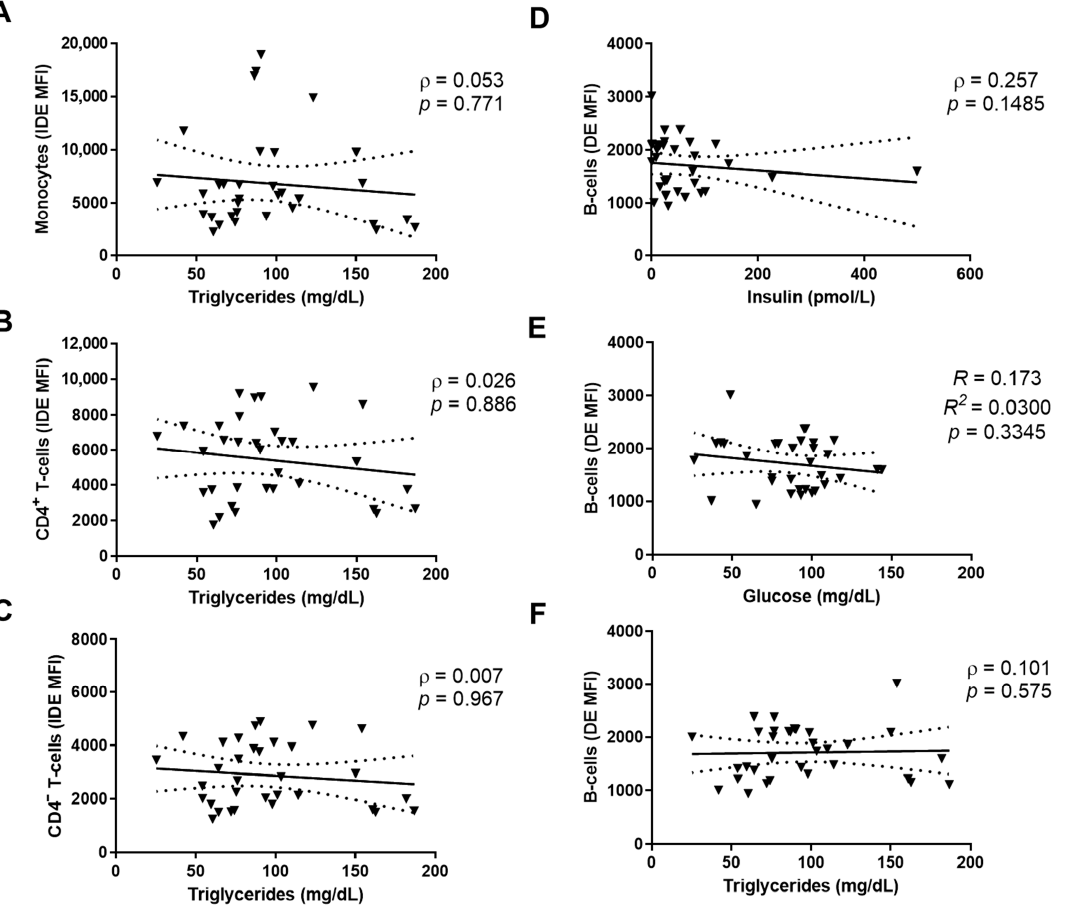
Figure A1. Regression analyses of the surface IDE and metabolic parameters in human PBMCs from COVID-19 and post-COVID-19 patients. Bivariate analyses were performed using data from COVID-19 and post-COVID-19 patients. Correlations between triglycerides and monocytes ( A ), CD4 + T-cells ( B ), and CD4 − T-cells ( C ) are shown. The Spearman’s correlation ( ρ ) and statistical sig- nificance ( p ) are indicated. Correlations between B-cells and insulin ( D ), glucose ( E ), and triglycer- ides ( F ) are shown. The R 2 or ρ coefficients and the statistical significance ( p ) are indicated.